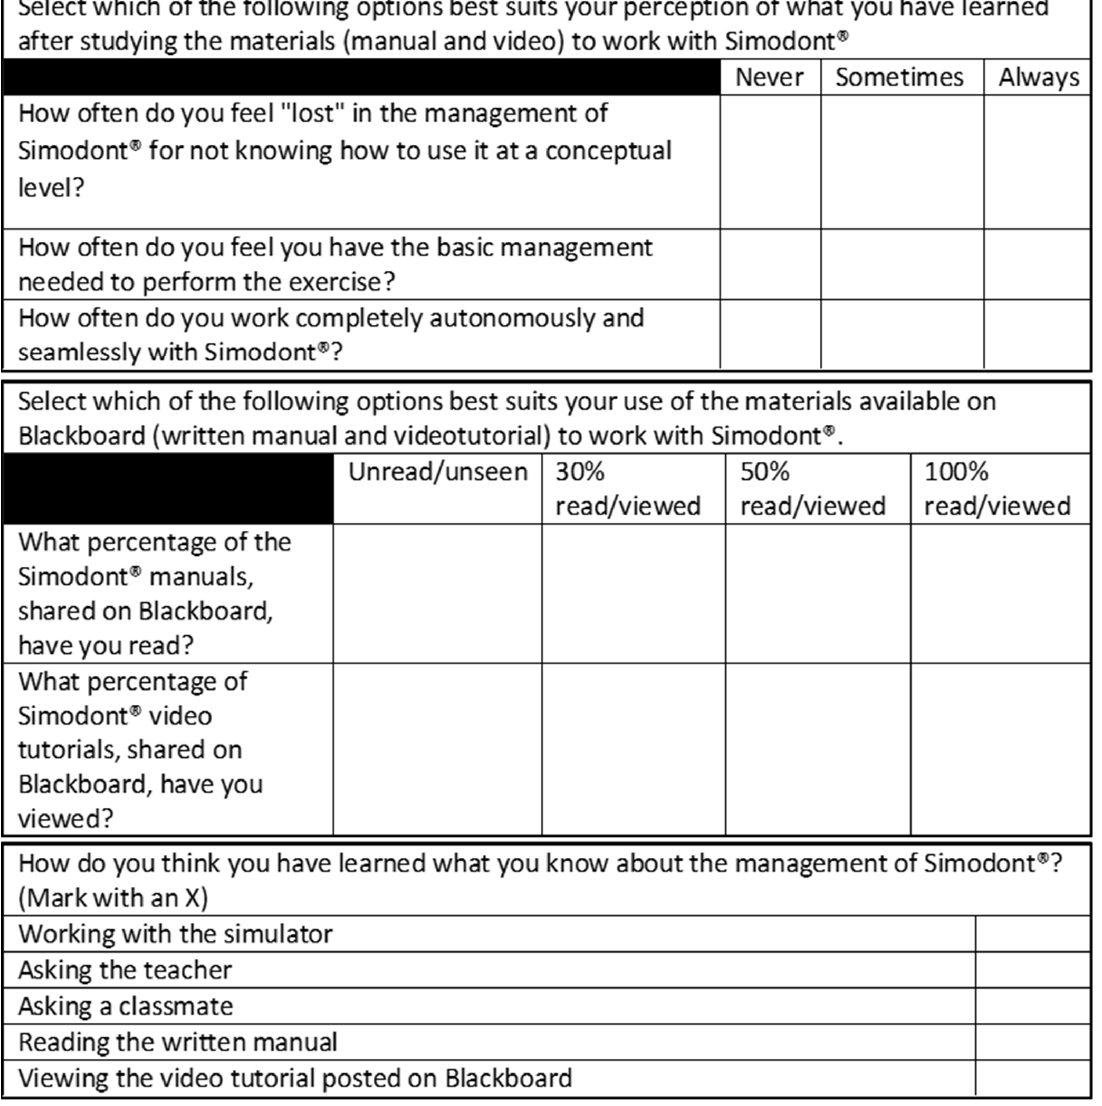
Figure 4. Questionnaire for students.